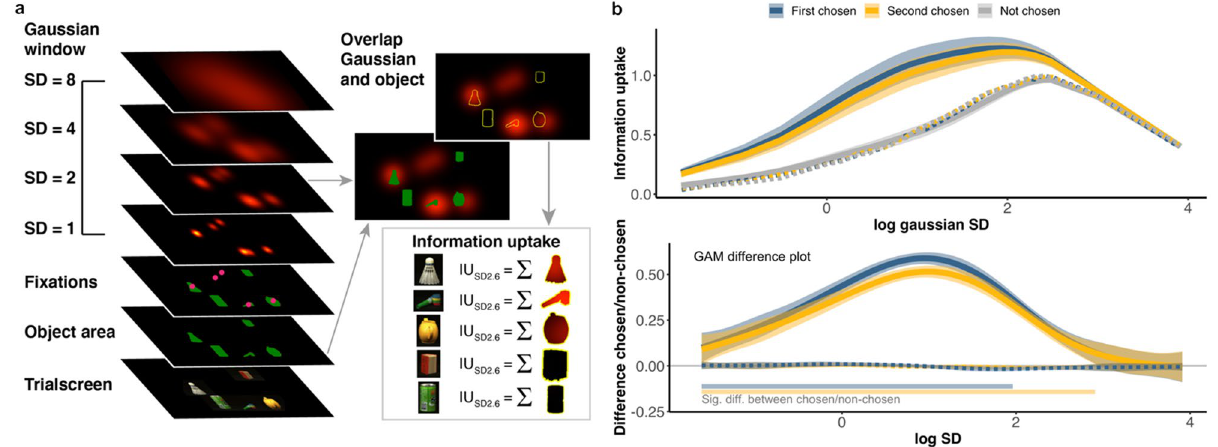
Figure 4. Overview of the information uptake model. ( a ) Information uptake was calculated by assuming Gaussian windows with different SDs around fixations for each trialscreen. Information uptake was calculated by summing the values of this Gaussian window across the object’s (x, y) pixel coordinates. Example overlap calculation is shown for the optimal window size, 2.6SD. ( b ) Top: Information uptake by report choice for first (blue), second (yellow) and not-chosen (grey) objects, by log SD of the Gaussian window. Dotted lines of the same colour indicate chance performance for each condition. Bottom: Difference between chosen and not- chosen objects from GAM models fitted to real (solid) and chance (dotted) data—note that the chance data overlap almost entirely. Error bars are 95% confidence